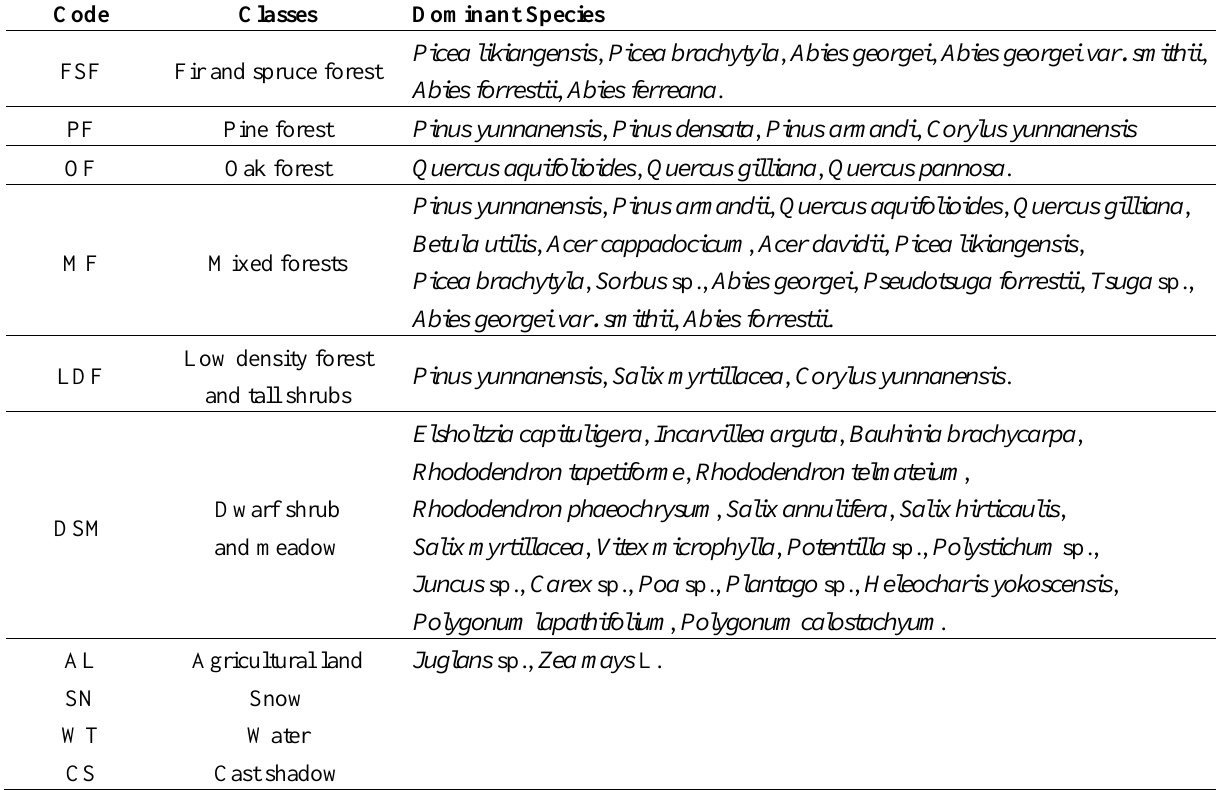
Table 2. The dominant vegetation classes and dominant species in the northern study area.